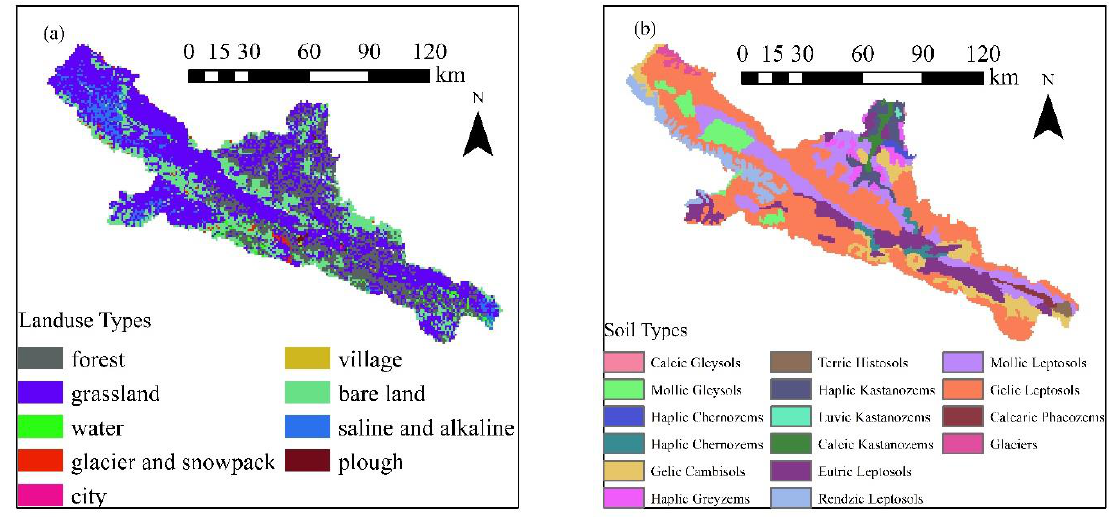
Figure 2. ( a ) Land-use and ( b ) soil maps of the upper Heihe River basin (UHRB).